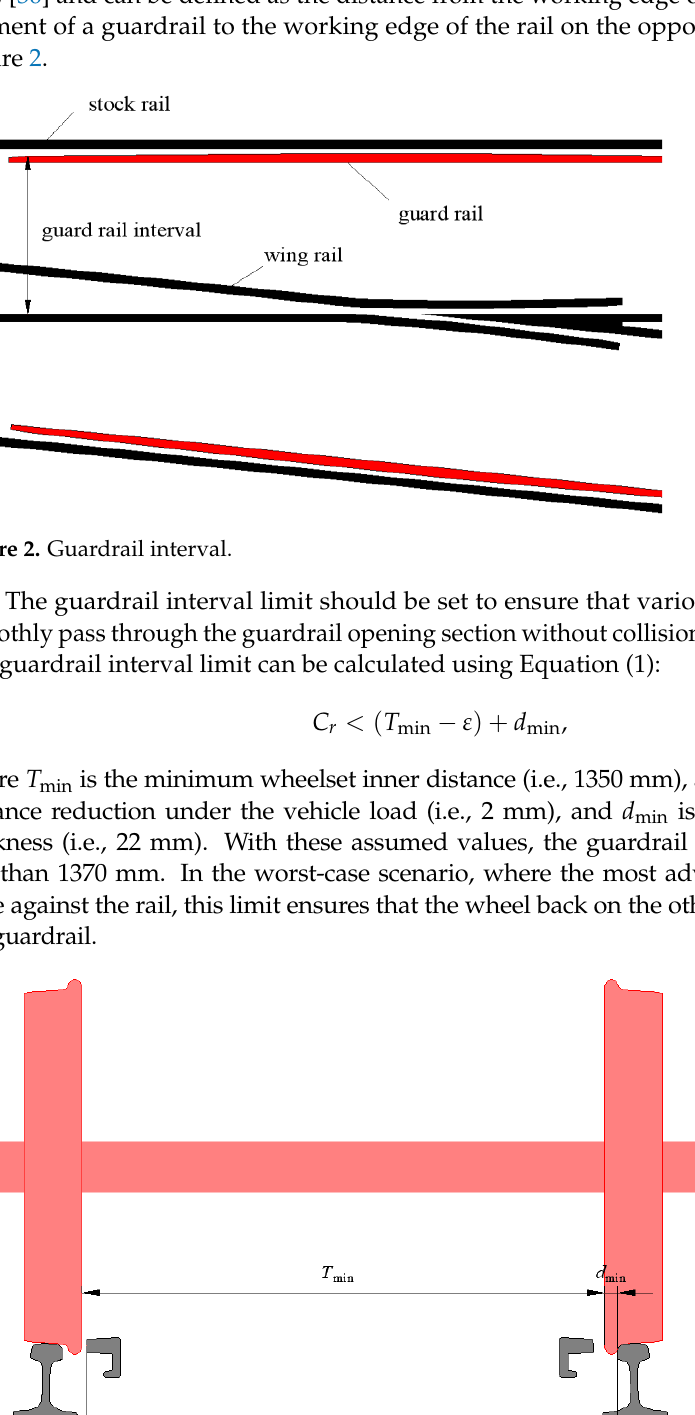
Figure 1. Schematic of derailment at the guardrail position in double-slip turnout.